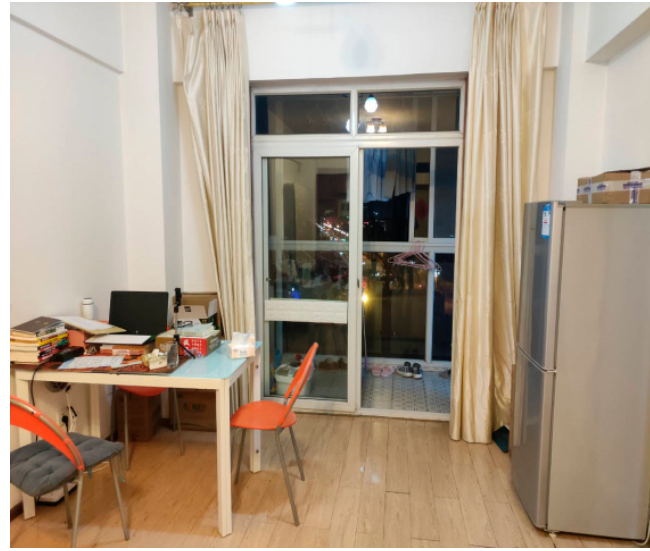
Figure 4. Ventilation opening of the balcony.